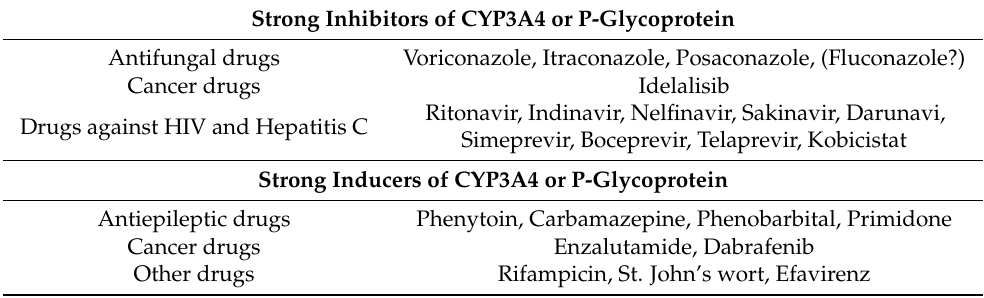
Table 7. Examples of drugs interacting with